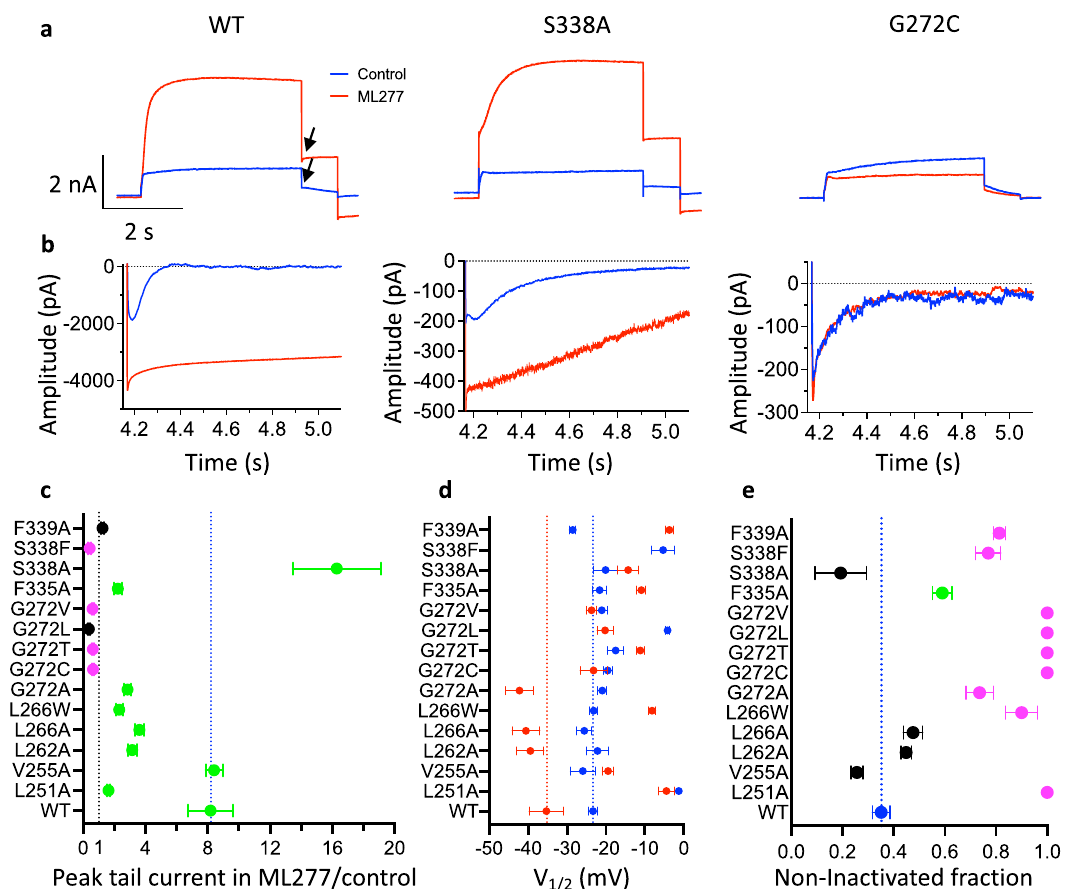
Fig. 7 Mutations to ML277 binding site residues reduce or eliminate drug effects on hKCNQ1. a Current traces in control (blue) and after addition of 1 μ M ML277 (red) for WT and mutant channels. Cells were held at − 90 mV, pulsed to + 60 mV for 4 s, then − 40 mV for 0.9 s. The interpulse interval was 15 s. Arrows show peak tail measurements for graph in panel c . b Tail currents at − 120 mV after 4 s pulses to + 60 mV in control (blue) and in ML277 for different mutants as indicated in a . Note: residue numbering in hKCNQ1 is + 10 compared with xKCNQ1. c KCNQ1 tail current amplitudes in ML277 divided by initial control tail, protocol as in panel a . Error bars denote mean ± SEM, n = 3 – 8 cells, (see Supplementary Table 2 for exact n values). Black indicates no drug effect; magenta indicates a signi fi cant decrease, and green indicates a signi fi cant increase from control (see Supplementary Table 2). Only V255A is not signi fi cantly different from WT, otherwise P = 0.008 – >0.001 using one-way ANOVA. d Mean V 1/2 of activation before (blue) and after (red) exposure to 1 μ M ML277. Protocol as in panel a . See Supplementary Table 3 for n and mean values and signi fi cance tests. For S338F, tail currents in ML277 were too small to measure. e Initial tail current amplitude in control divided by extrapolated fi t to tail current decay, as a measure of channels that are not inactivated at the start of the tail, values represent the mean ± SEM. WT is blue, not signi fi cantly different from WT is black, signi fi cantly less inactivated than WT, P < 0.05 (green) and P < 0.01 (magenta). Where no hook was observed, a value of 1 is given for non-inactivated fraction, e.g., L251A and G272C ( b ). Note that in some cases error bars fall within plotted symbols. n = 4 cells for L262A, L266A and F335A, n = 5 cells for L266W, G272V and S338F, for all others n